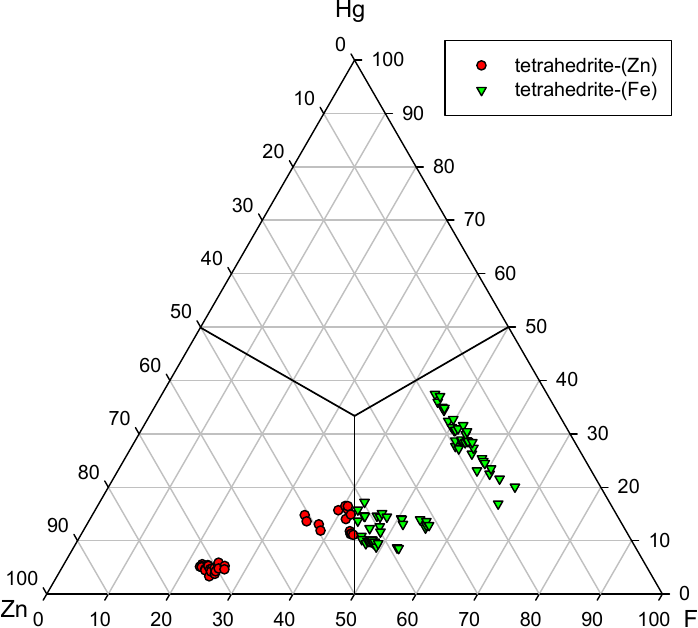
Figure 18. Ternary plot Fe–Hg–Zn ( apfu ) for members of the tetrahedrite group.